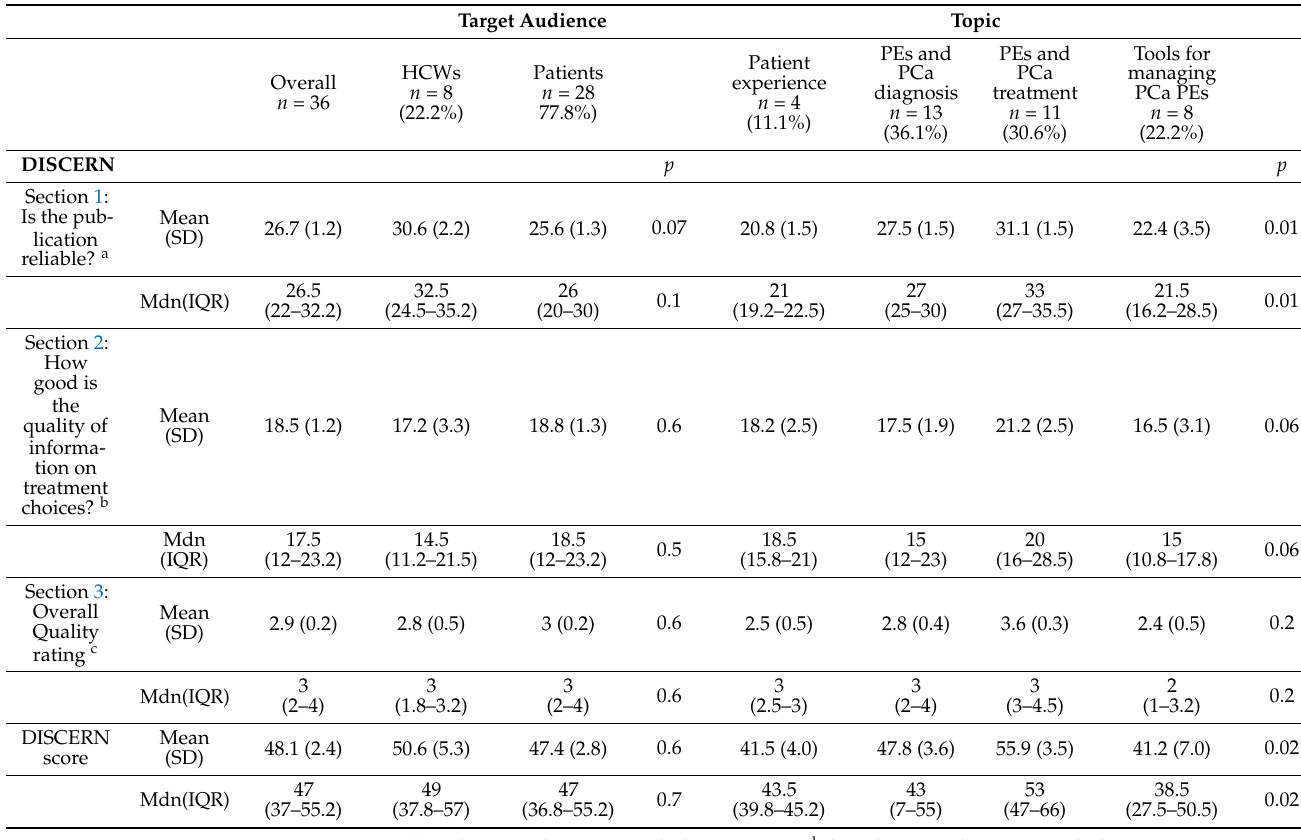
Table 4. DISCERN instrument Section 1, Section 2, and Section 3 of 67 YouTube videos on mental health of PCa patients stratified according to target audience (healthcare workers vs. patients) and topic (patient experience vs. psychological effects and PCa diagnosis vs. psychological effects and PCa treatment vs. tools for managing PCa psychological